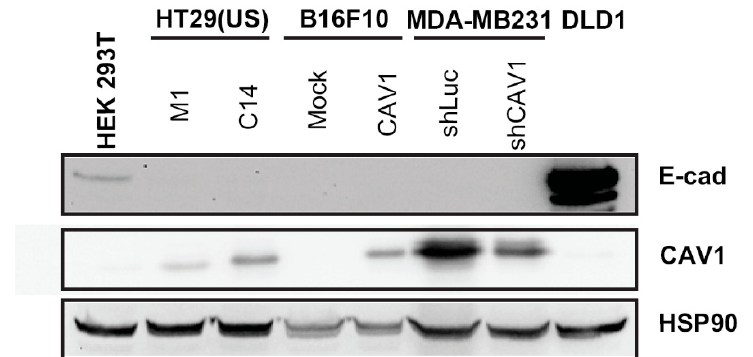
Figure 1 . E-cadherin protein levels expressed in different cell lines. HEK293T, HT29(US) (clones M1 and C14), B16F10 (Mock and Caveolin-1 (CAV1)), MDA-MB231 (shLuc and shCAV1) and DLD-1 (positive control for E-cadherin expression) cell lines were maintained in culture at less than 70% confluency. To induce CAV1 expression, HT29(US) and B16F10 cells were incubated 24 and 48 h with isopropyl-b-D-thioglactopyranoside (IPTG) 1mM, respectively. Then, cells were lysed and cellular extracts were analyzed for the presence of E-cadherin (E-cad), CAV1, and HSP90 (loading control) by Western blotting.